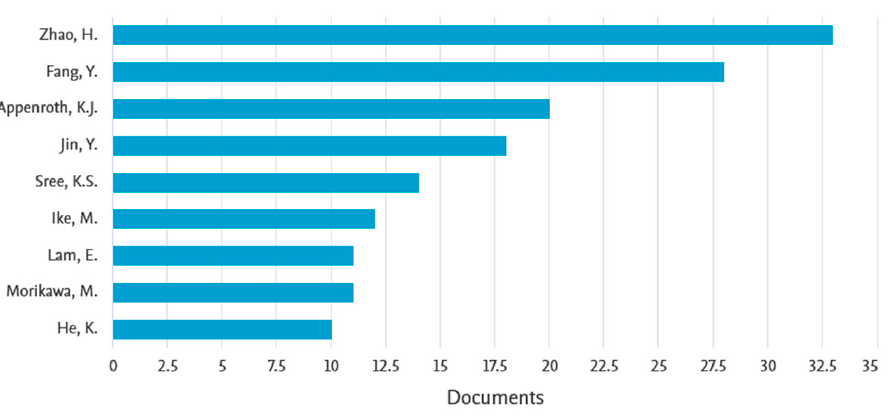
Figure 5. The most productive authors within the studied research domain. Sciences ) (more than 30 articles per organization) (Figure